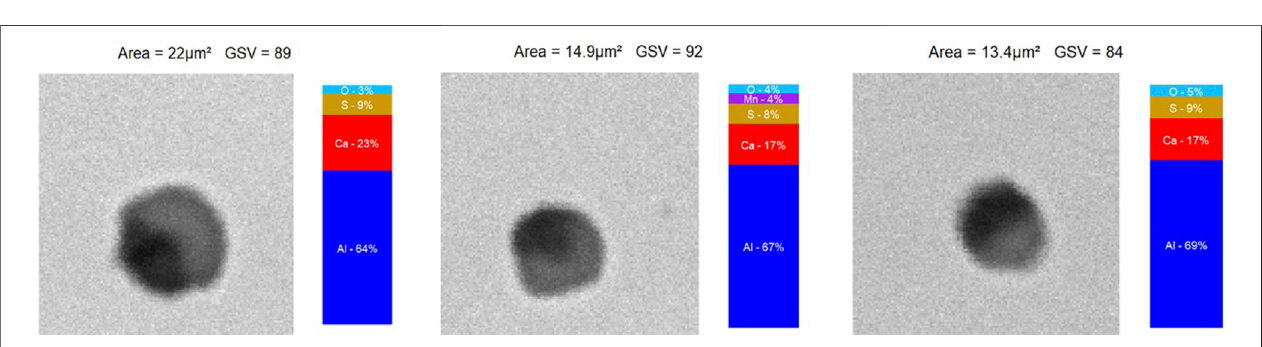
FIGURE 9 | Examples of inclusions classi fi ed as “ CA ” by standardized criteria but predicted as “ oxy-sul fi de. ” Composition bar is displayed to the right of each BSE image.